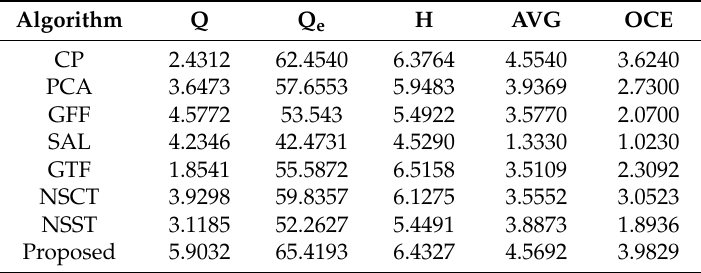
Table 4. Comparison of evaluation results of fourth